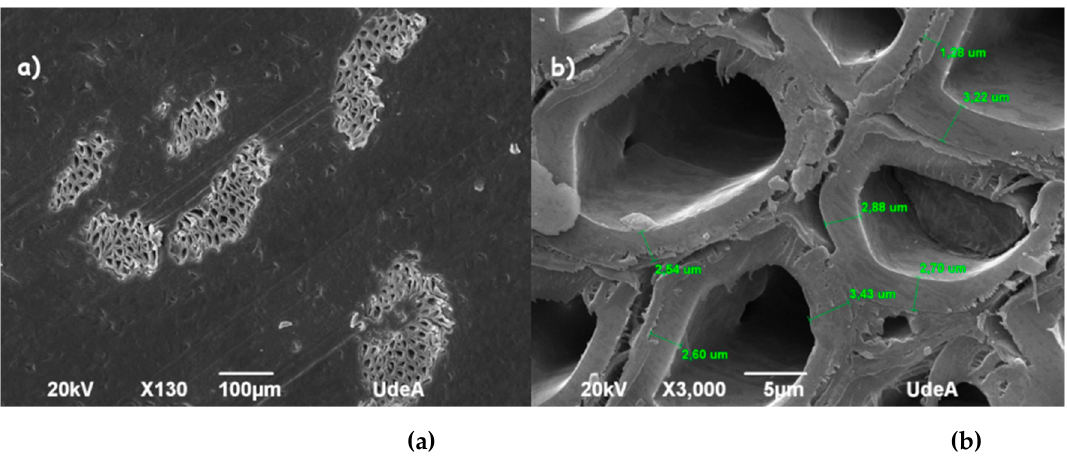
Figure 3. SEM ( a ) micrographs of fique fibers and ( b ) lamella media and lumen of fique fibers.